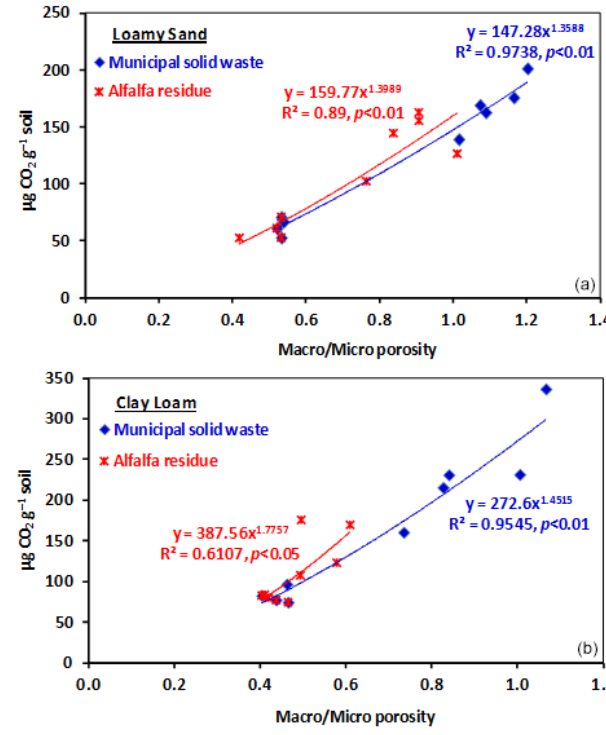
Figure 2. Relationship between the total porosity and soil microbial respiration of loamy sand (a) and clay loam (b) soils, treated with different levels of municipal solid waste (MSW) and alfalfa residue (AR).